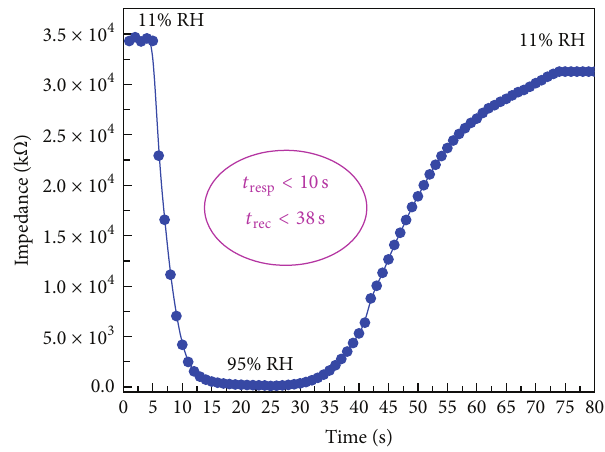
Figure 7: The response and recovery properties of humidity sensor.